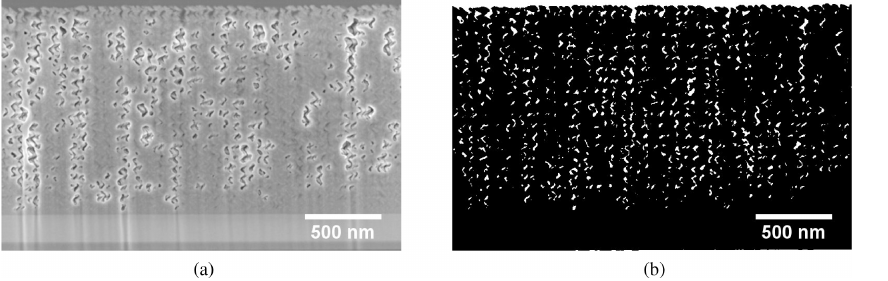
Figure 10. Cross section of tantalum spiral structures deposited at α = 80 ◦ and P ω = 162nm per revolution. (a) SEM image of the FIB-sliced sample; (b) segmented FIB-SEM